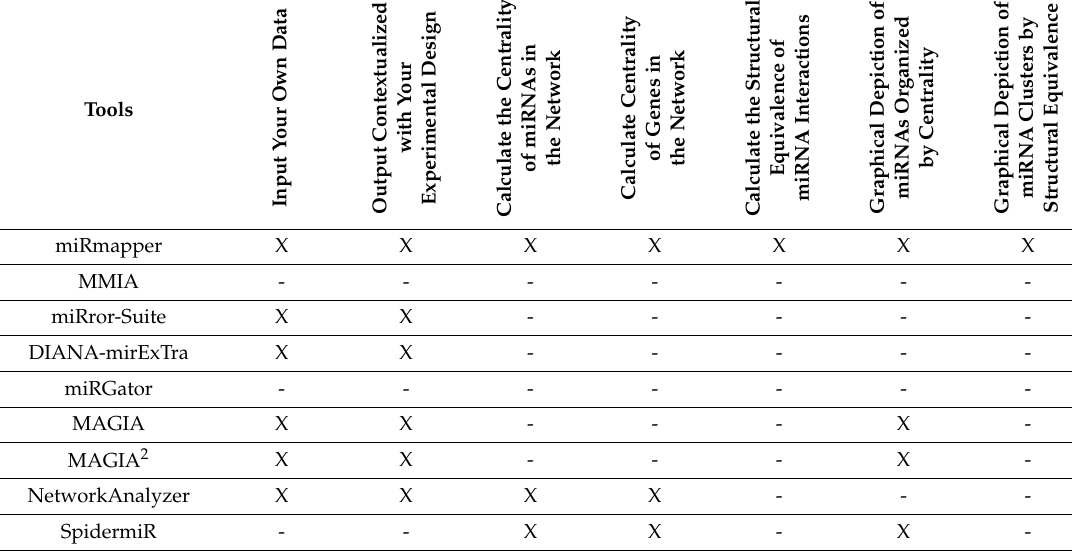
Table 1. Tool comparison. Each column represents a feature and each row represents a software tool.